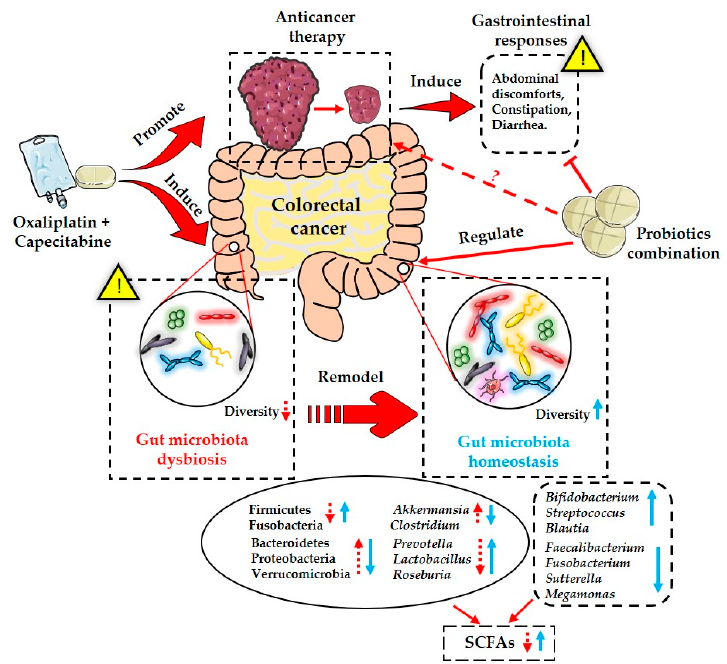
Figure 6. Schematic diagram of actions of probiotics combination in attenuating chemotherapy-induced gastrointestinal responses and gut microbiota dysbiosis. Supplementary Materials: The following supporting information can be downloaded at: www.mdpi.com/xxx/s1, Figure S1: Comparison of the differences of α and β diversities among CRC patients; Figure S2: Spearman correlation analysis between SCFAs and the altered gut microbial genera; Table S1: Comparison of blood routine test between CRC patients in placebo and probiotics groups.